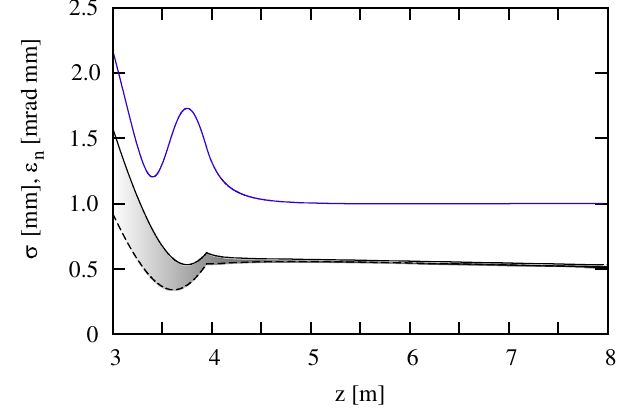
FIG. 11. Emittance (blue line) and slice size (high perveance, solid line; low perveance, broken line) in an accelerating section with γ 0 ¼ 41 . The development between z ¼ 0 and 3 m is shown in Figs. 3 – 9. The starting position of the accelerating section is at z ¼ 3 . 9 m.